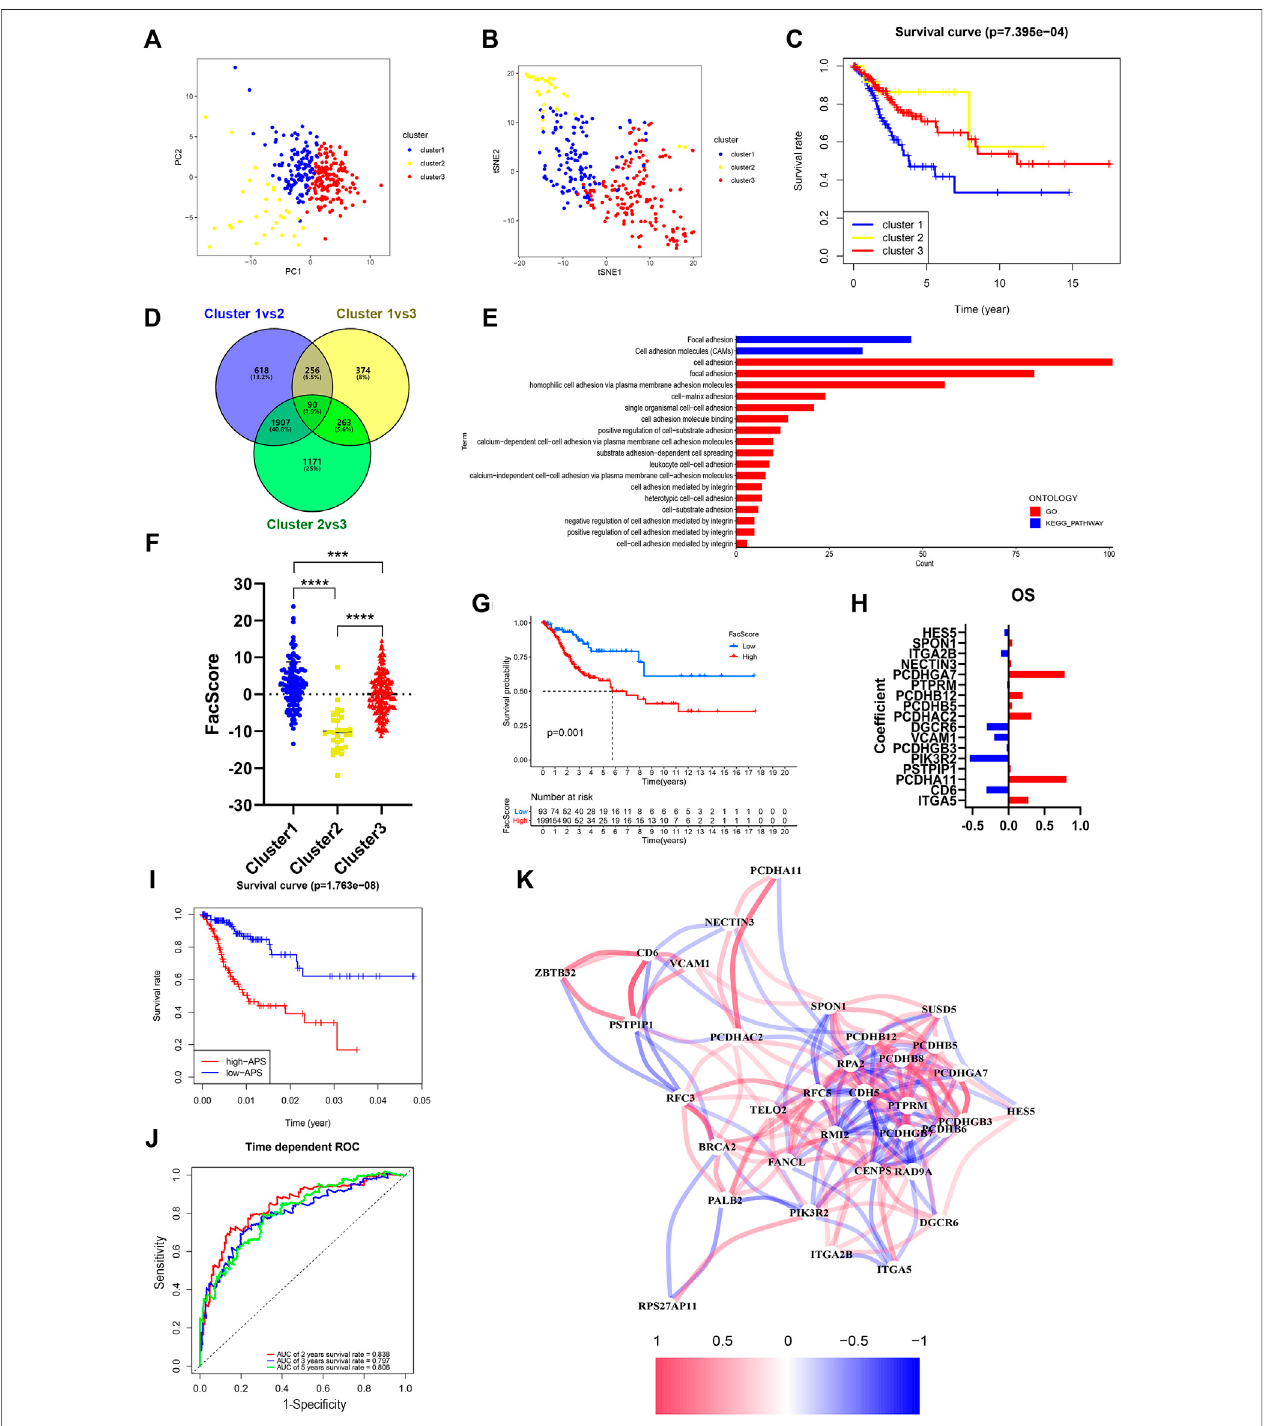
FIGURE 4 | Identi fi cation and characteristic description of the consensus cluster and build cell adhesion signature APS based on FARGs. (A,B) Consensus clustering for k (cid:1) 3 based on FARGs expression pattern and visualization by PCA (A) and t-SNE (B) . (C) Kaplan-Meier survival curve for patients in different clusters. (D) Venn diagramshowingtheDEGsobtained fromthecomparisonbetweeneach ofthetwosubgroups. Thecutoffvalueis|log 2 FC| > 1and p -value < 0.05. (E) Thefunctionenrichment result based on the DEGs and the bar chart showing the cell adhesion related pathways. (F) Representation of the cluster character by FacScore calculated by adhesion genesexpressionpattern.*, p < 0.05;**, p < 0.01;***, p < 0.001. (G) Kaplan-MeiersurvivalcurvesforpatientswithhighandlowFacScore. (H) Thesignaturecoef fi cientsofOS. (I) Kaplan-MeiersurvivalcurvesforpatientswithhighandlowAPSbasedoncelladhesionsignature. (J) ROCcurvesbasedonAPSfor2-,3-,and5-yearssurvivalprobabilities. (K) Correlation network of FARGs and cell adhesion associated genes. PCA, principal component analysis; t-SNE, t-distributed stochastic neighbor embedding.